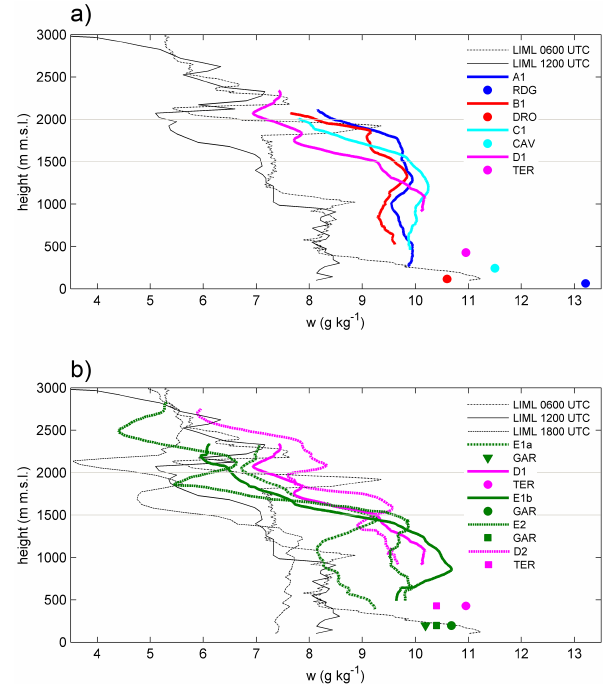
Figure 5. θ pseudo-soundings: (a) profiles for sites A, B, C and D (Sarca and Lakes valleys) from flight 1; (b) profiles for sites D and E (i.e. Terlago saddle area and Adige Valley) from flights 1 and 2 (cf. Table 1). Associated surface observations from the AWS closest to each site are also reported, as representative of local surface layer conditions (see Fig. 2 and Table 2 for station names). Milan (LIML) radiosoundings launched at 06:00, 12:00 and 18:00UTC (i.e. 07:00, 13:00 and 19:00LST) are displayed as black lines. The elevation range of the surrounding crests is indicated in grey.